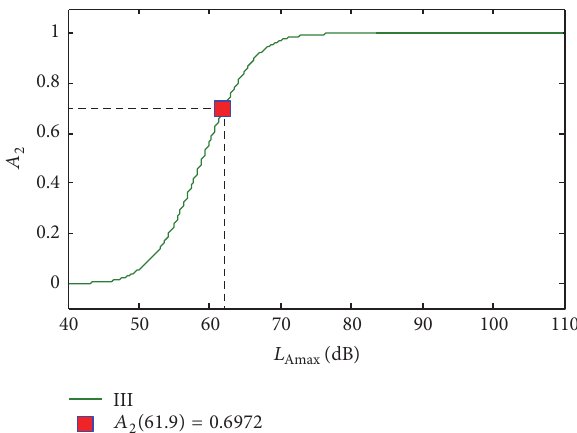
Figure 11: Contour map of combined annoyance degree in the surveyed